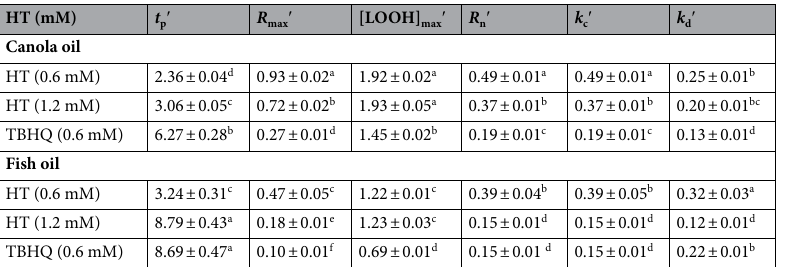
Table 4. The relative quantities of the propagation kinetic data shown in Table 2. Means ± SD (standard deviation) within a column with the same lowercase letters are not significantly different at P <